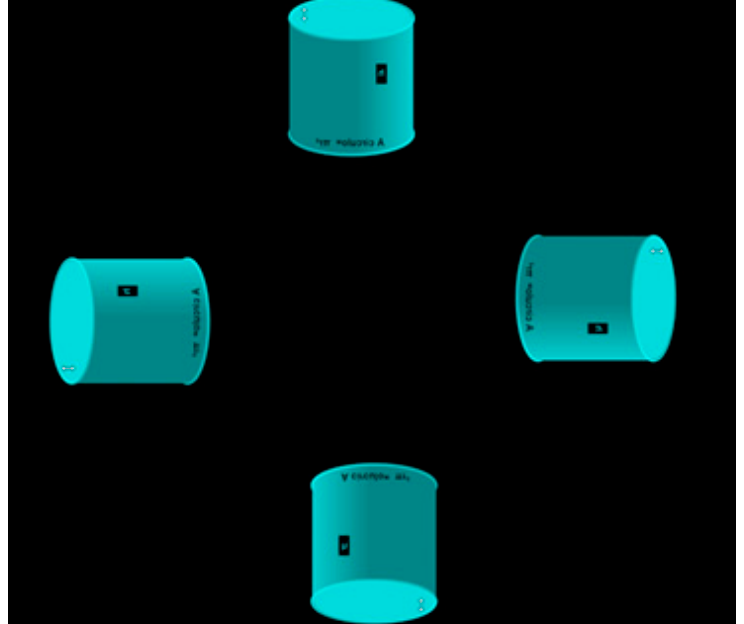
Figure 1. Image taken from the video of the volume calculation of the cylinder to be projected with the hologram.